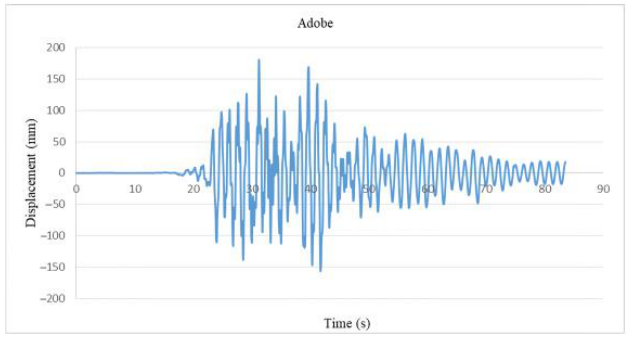
Figure 18. Time-displacement curve for minaret made of adobe.